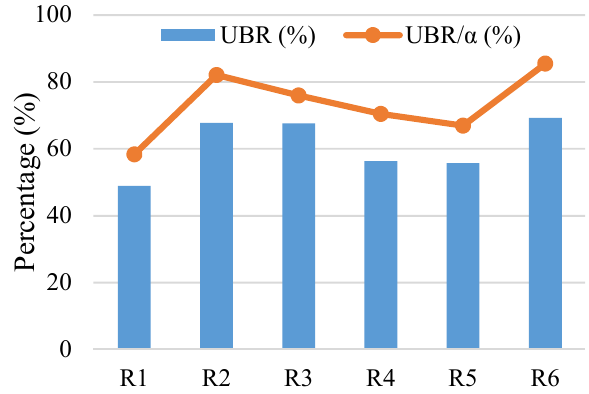
Fig. 4: Biogas yield and biogas composition from experiments Table 4. Characteristics of methane and carbon dioxide kinetics